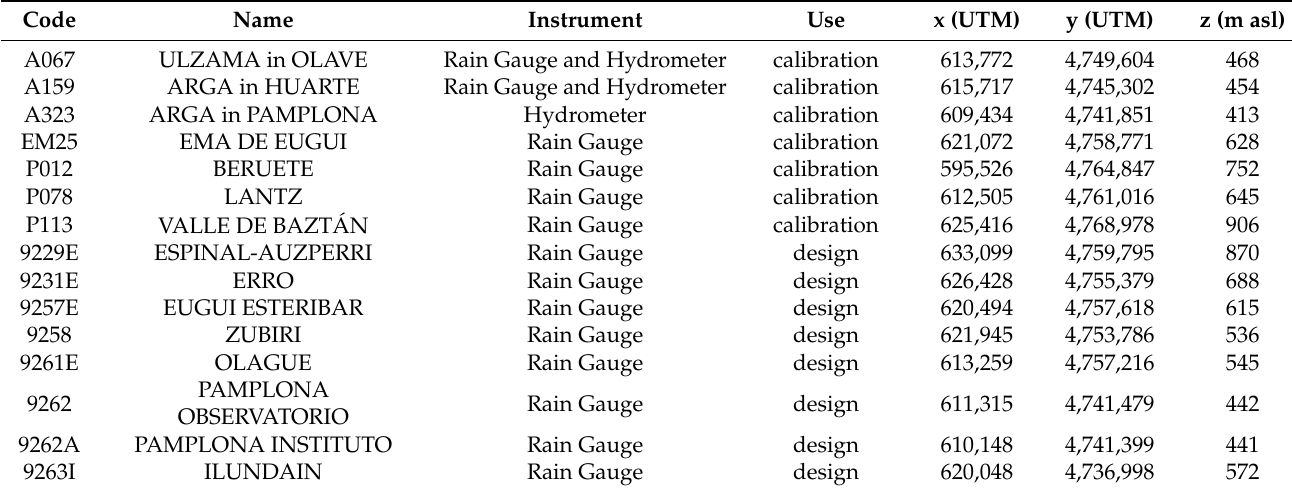
Table 2. Summary about the rain- and streamflow-gauge stations considered in the study.